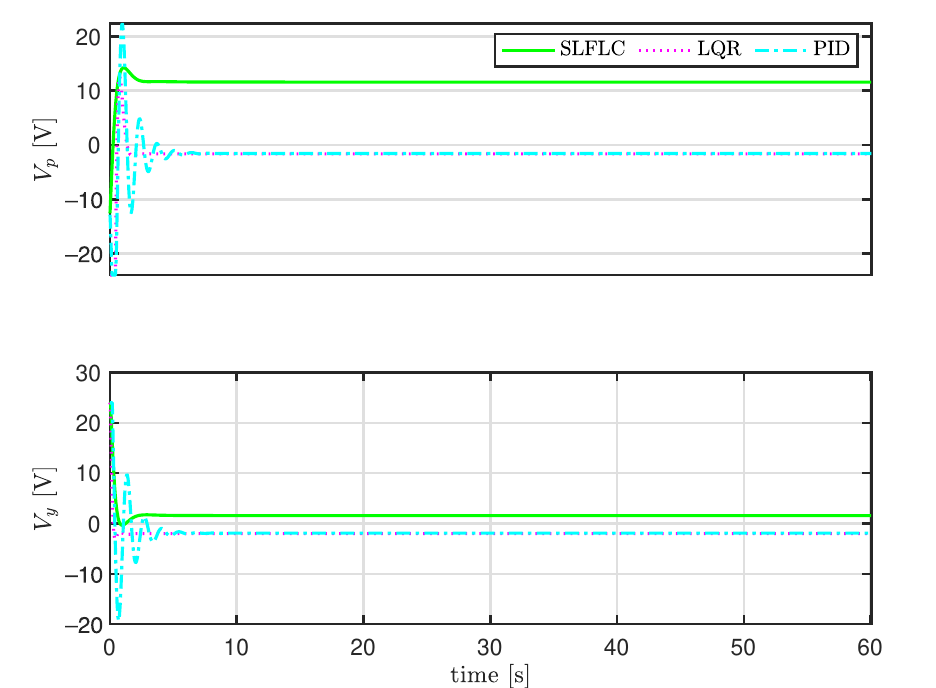
Figure 11. Input voltages (case